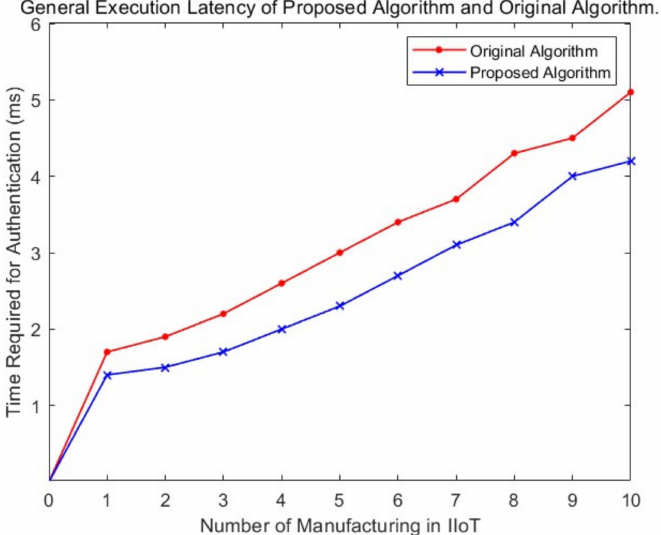
Figure 4. Authenticated time of the proposed Blockchain algorithm.